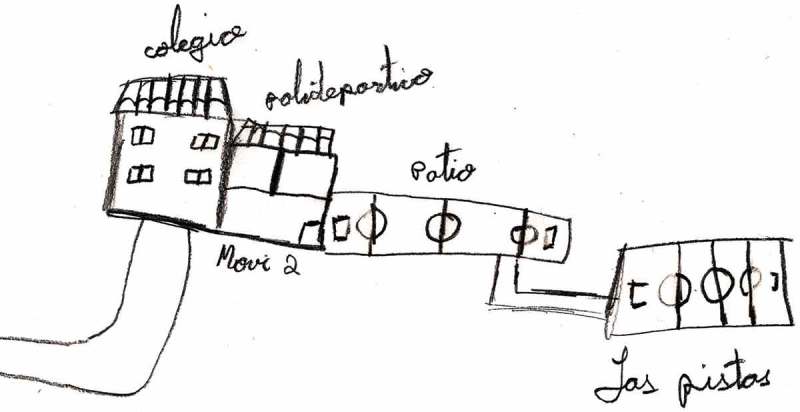
Boy, rural area.jpg.